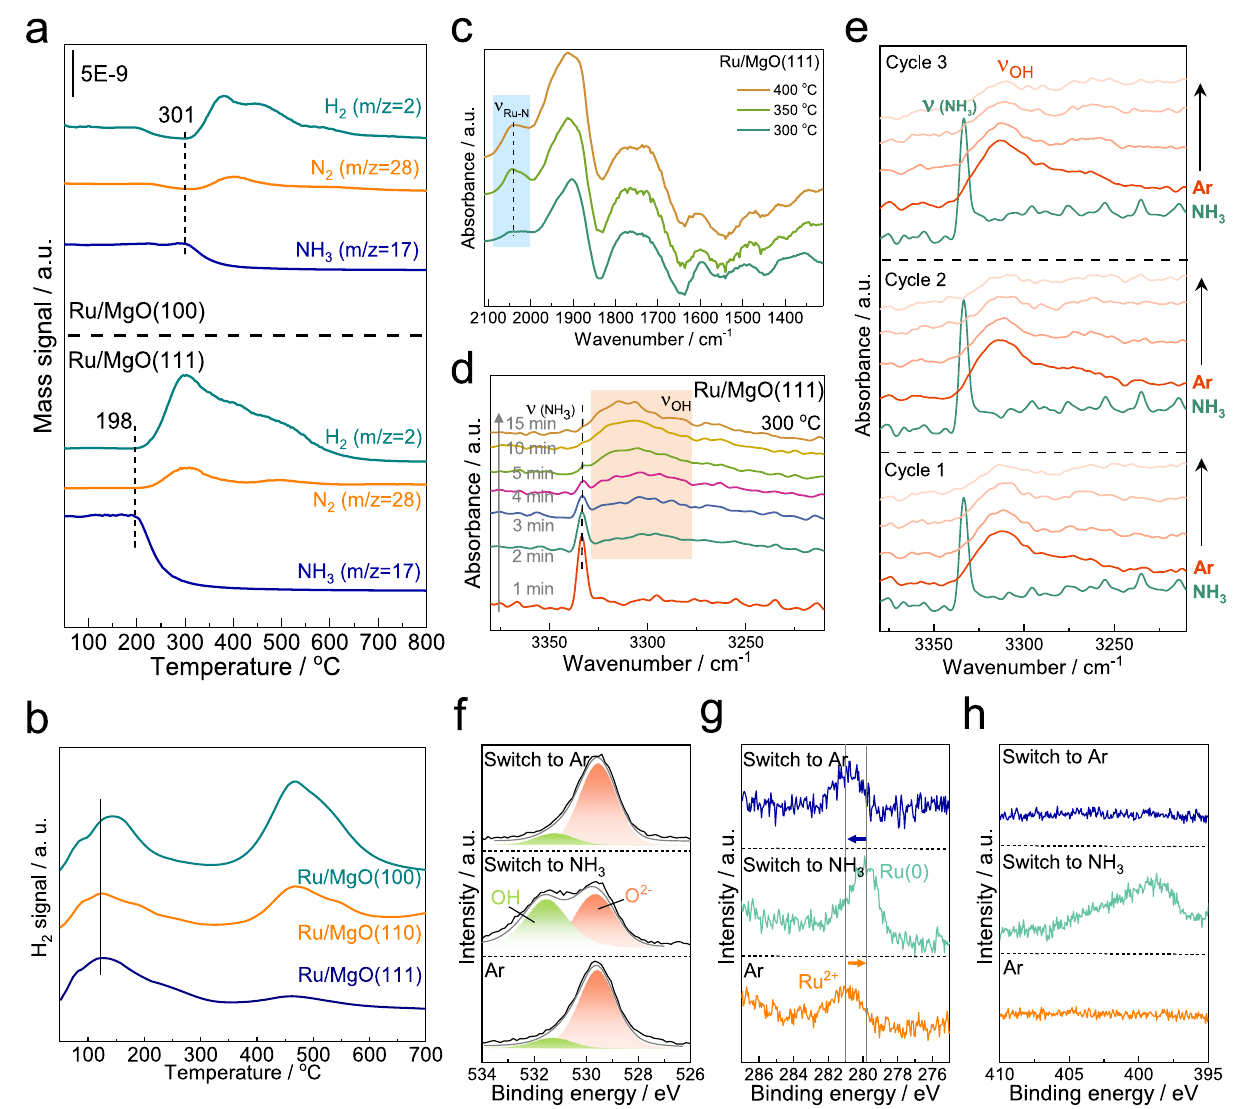
Fig. 4 | Characterizations of verifying the effect of hydrogen hopping in ammonia decomposition. a TPSR over the Ru/MgO(111) and Ru/MgO(100) based on the NH 3 decomposition reaction; b H 2 -TPD pro fi les of supported Ru samples; c in situ DRIFTS study of NH 3 adsorption over Ru/MgO(111) under different tem- peratures; d time-resolvedDRIFTSofNH 3 transformationasafunctionoftimeover